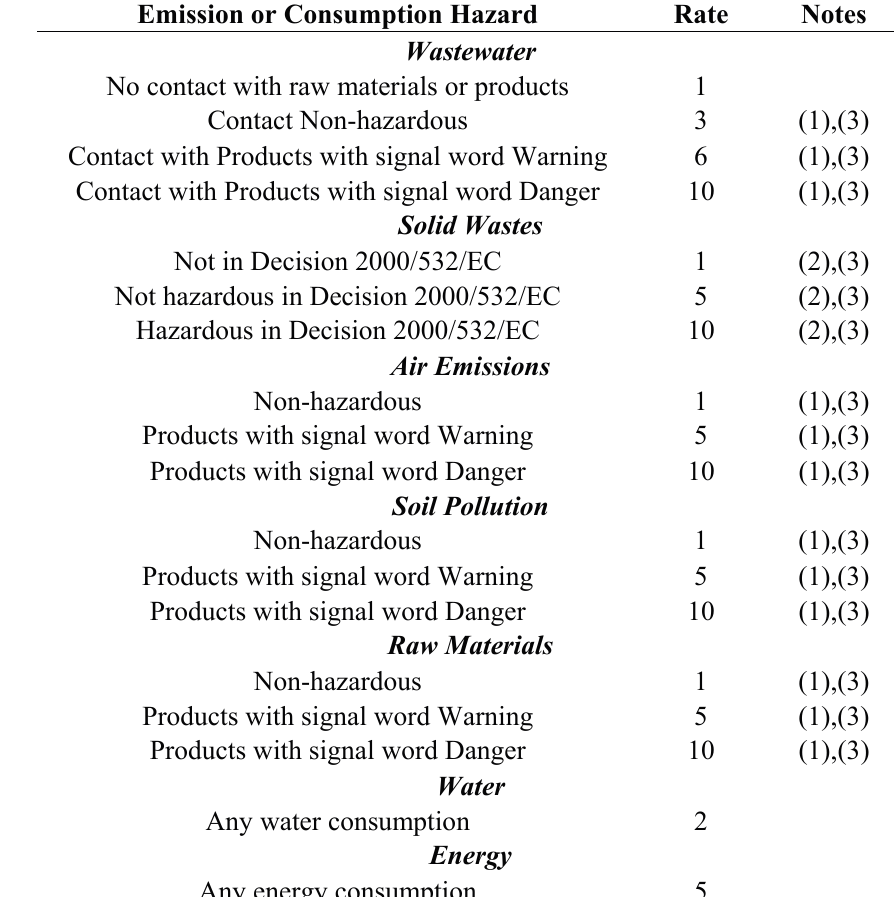
Table 3. Parameter B (Hazard): Numerical values for Parameter B, assigned by how hazardous each event